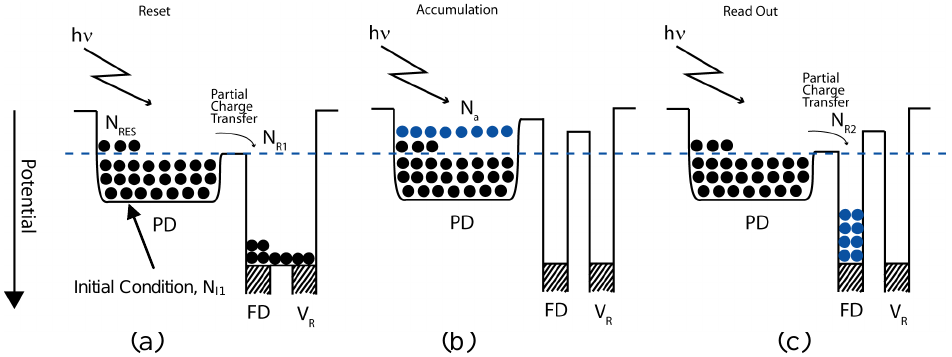
versus accumulated electrons within R2